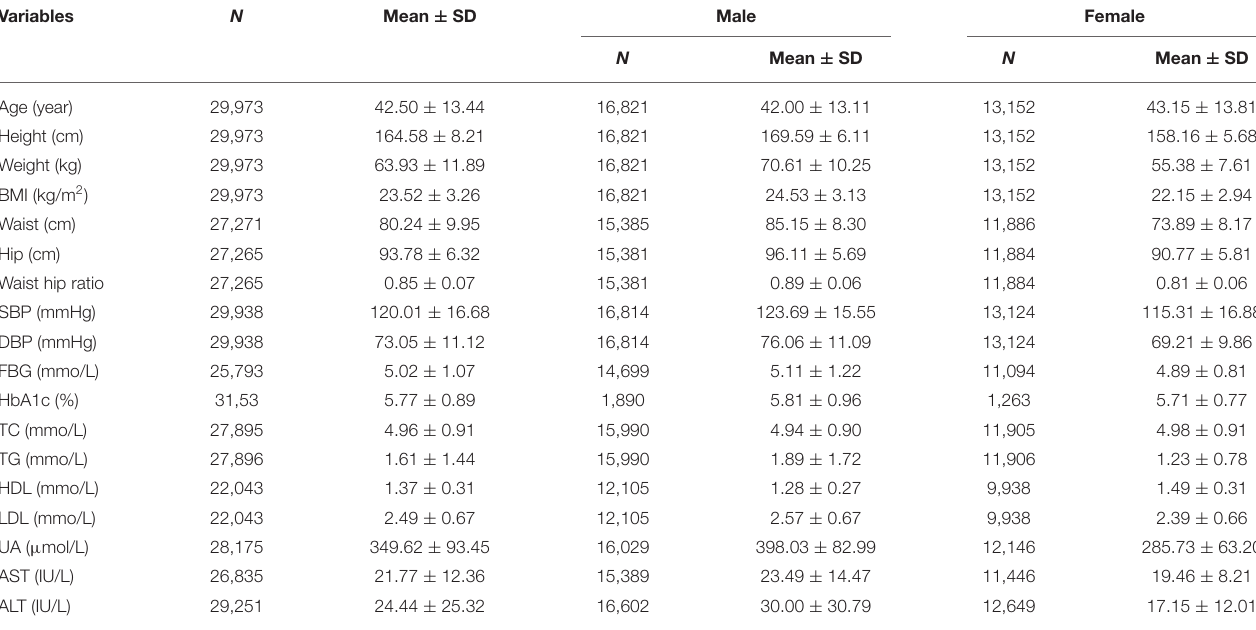
TABLE 1 | Characteristics of participants at baseline of